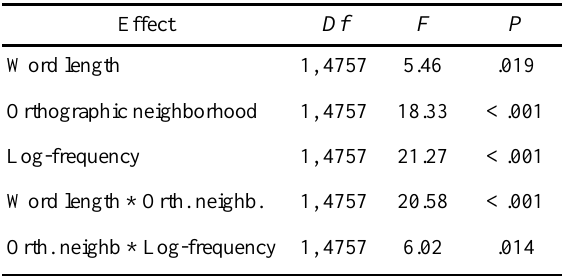
Table 2. First-Fixation Duration: ANOVA